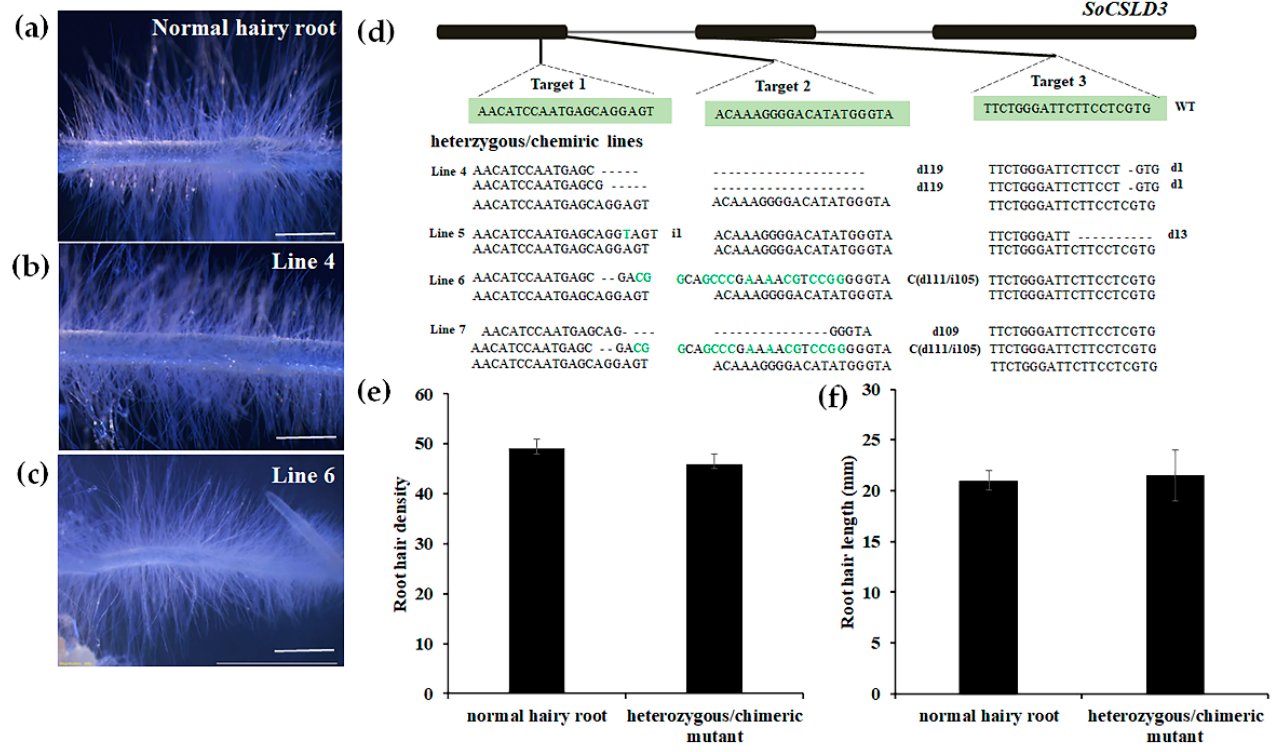
Figure 4. Phenotyping and genotyping of edited hairy root lines of SoCSLD3 . ( a – c ) The root-hair phenotype of normal hairy root ( a ), line 4 (chimeric line) ( b ) and line 6 (heterozygous line) ( c ) of SoCSLD3 . Bar = 20 µm. ( d ) The mutation types of the line 4, line 5, line 6, and line 7 (heterozygous mutated line). The mutation types of each target were labeled in right of the target sites, respectively. Deletion bases were indicated by dashed lines; d#, number of bases deleted from the target site. Insertion bases were marked in green; i#, number of bases inserted at the target site; c, combined mutations (more than one mutation type in one allele). ( e ) Root-hair density and ( f ) root-hair length analysis of normal hairy roots and heterozygous/chimeric mutant lines of hairy root. Root-hair length and density were measured at the region 1.5 to 2 mm from the root tip. Root-hair density is shown as root-hair number per mm 2 ; 24 roots of three lines (8 roots for each line) were measured for each mutation type, and the values were mean ± SD.